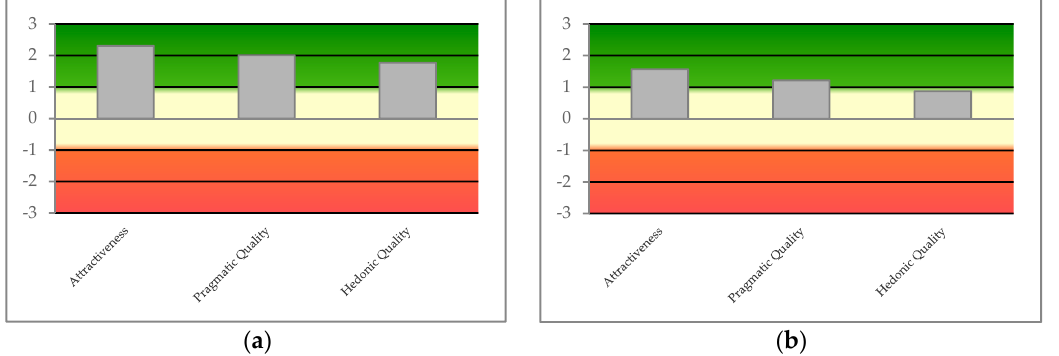
Figure 3. Evaluation results from an attractiveness, pragmatic, and hedonic quality point of view: ( a ) The results for the prototype evaluation, ( b ) the results for the Google Home.